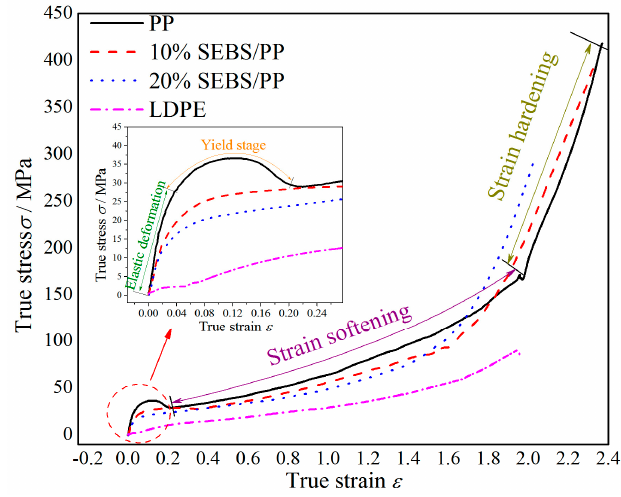
Figure 7. Stress-strain characteristics of the SEBS/PP composites and LDPE.